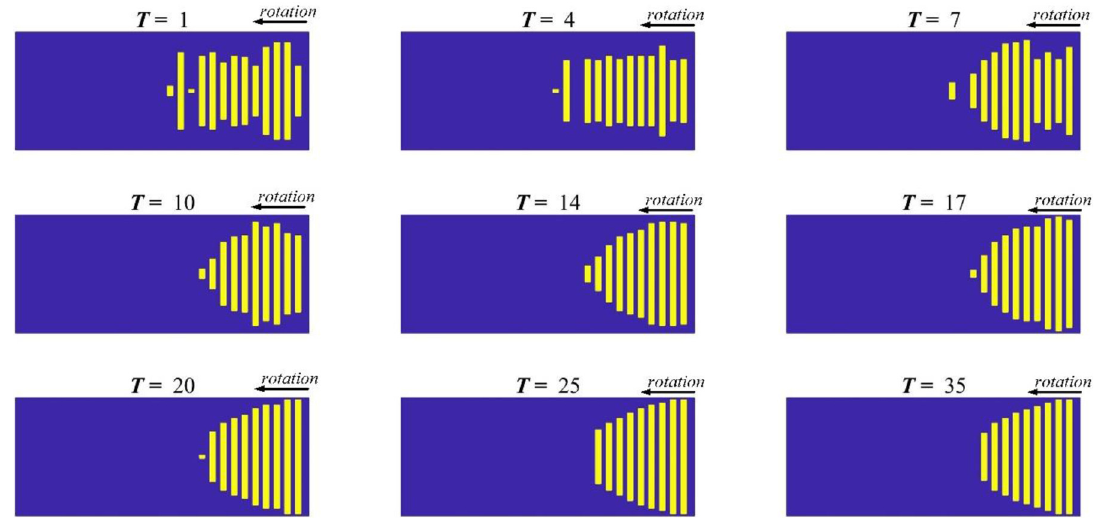
Fig. 6. The progressive changes of distributions under e =0.1, ’